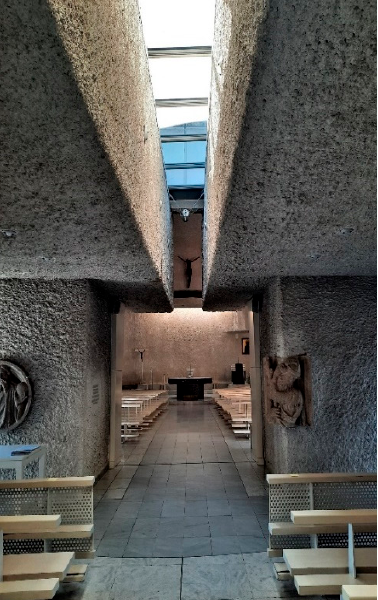
Figure 4. Perspective toward the altarpiece seen from the Chapel of the Confession. The vein of sunlight guides the devotees toward the main hall.